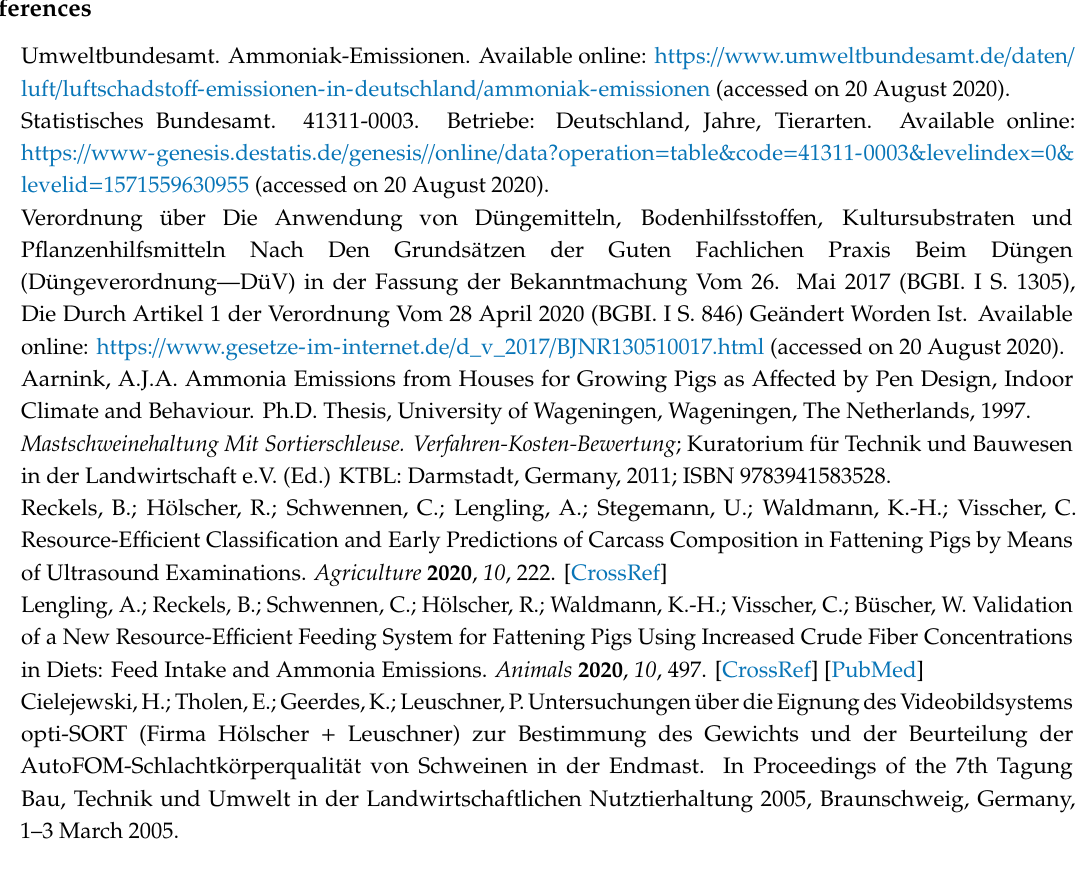
Table S1: Chemical composition of supplementary feed “SF1”, and “SF2”, as well as “Soybean Oil”, according to the declaration (88% dry matter content; DM). Triticale whole-plant-silage (WPS) and the Corn-Cob-Mix (CCM) were analyzed in the Institute for Animal Nutrition Hanover (88%